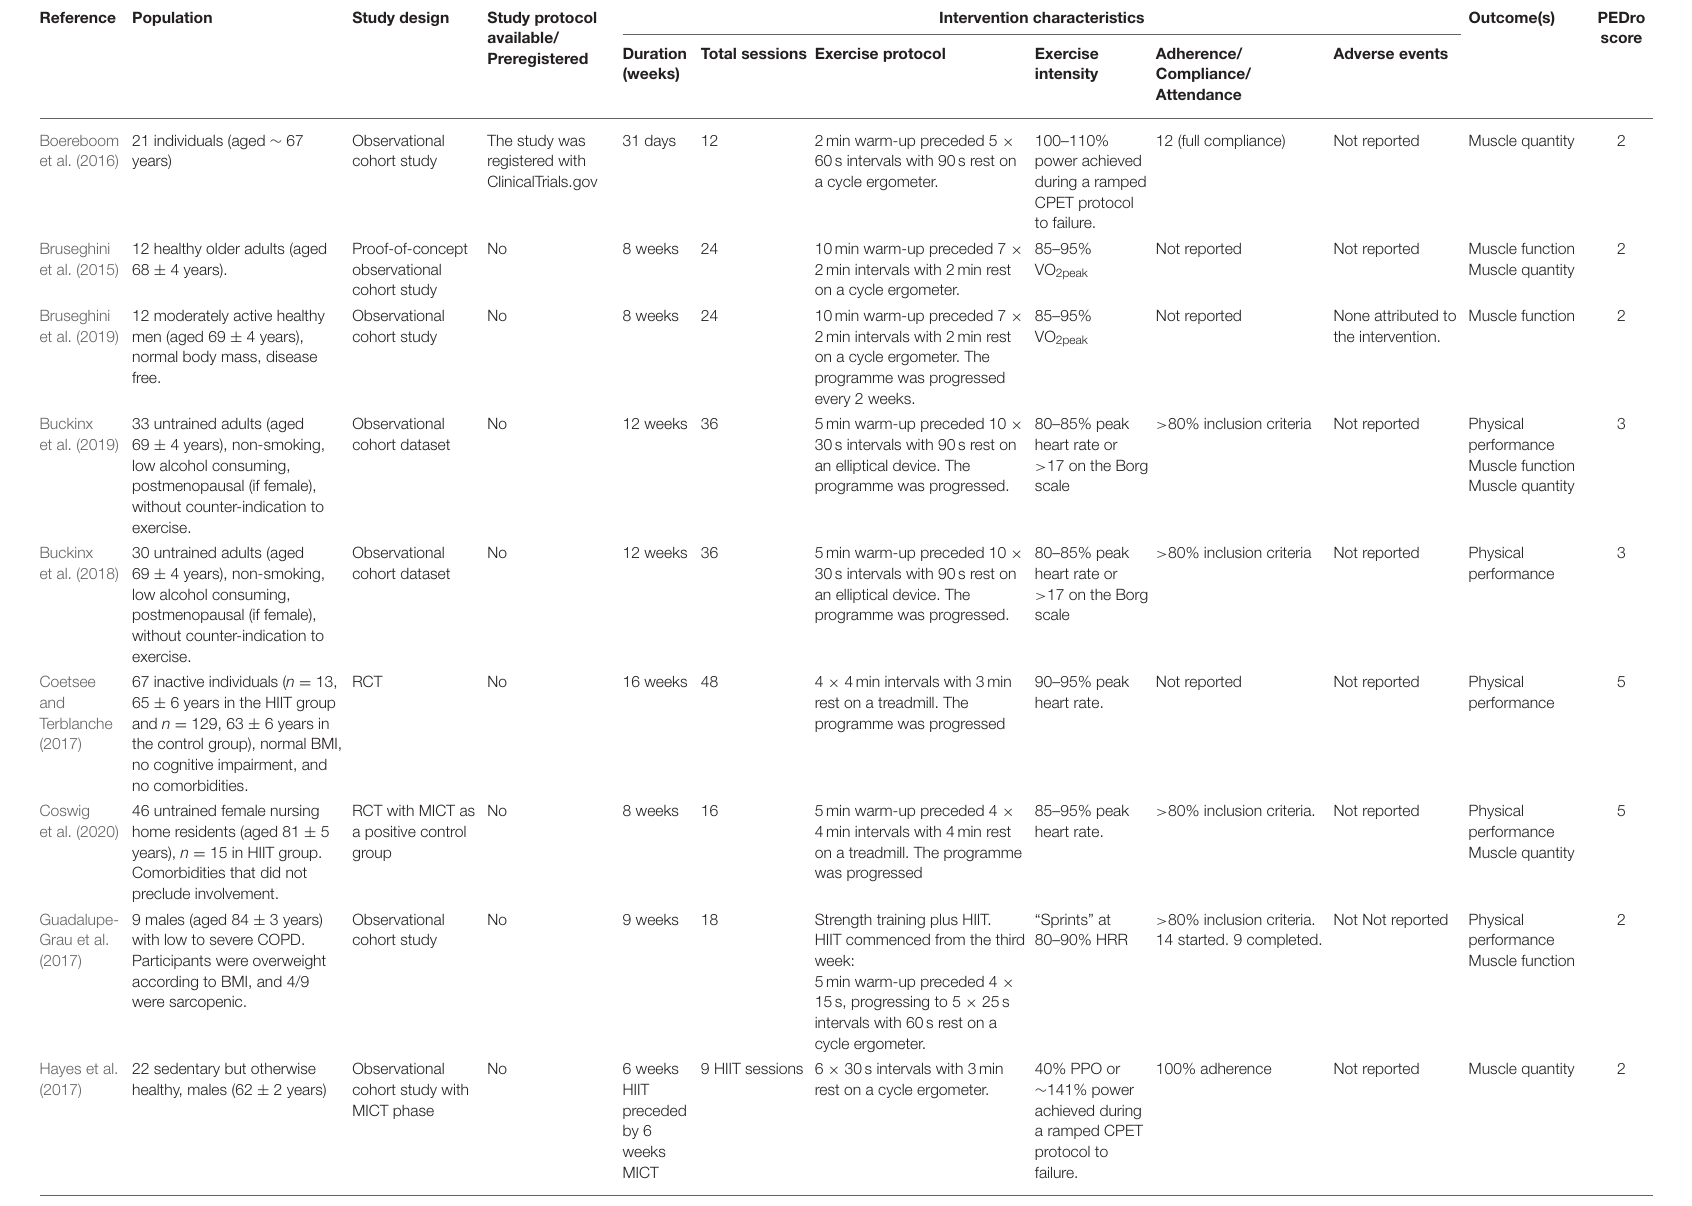
intervals with 60s rest on a cycle